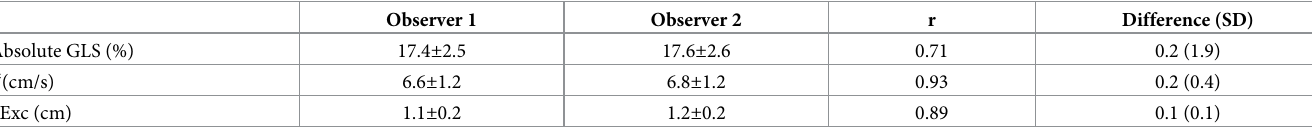
Table 5. Reproducibility